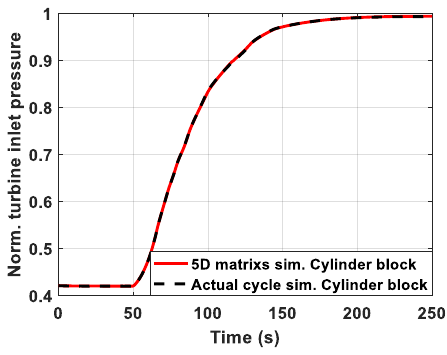
Figure 12. Turbine inlet pressure time history.